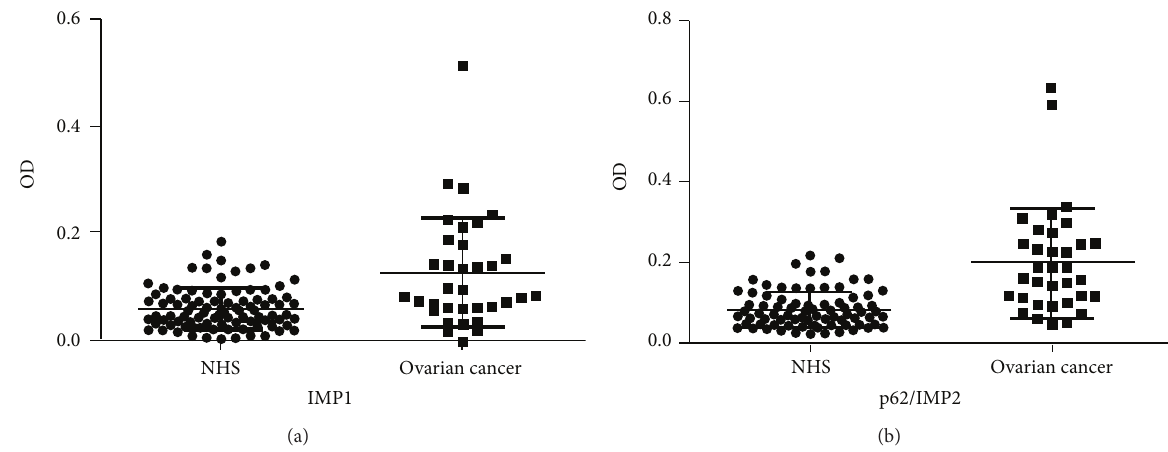
Figure 1: Titer of autoantibodies against IMP1 and p62/IMP2 in human sera by ELISA. The range of antibody titers to IMP1 and p62/IMP2 was expressed as optical density (OD) obtained from ELISA. The mean + 3SD of NHS is shown in relationship to all serum samples. Titer of anti-IMP1 and anti-p62/IMP2 in ovarian cancer is much higher than that in NHS ( 𝑃 < 0.01 ).